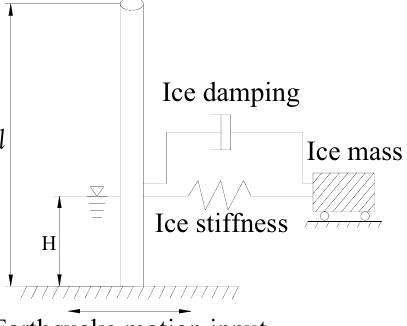
Figure 1. Calculation method of dynamic interplays between ice and